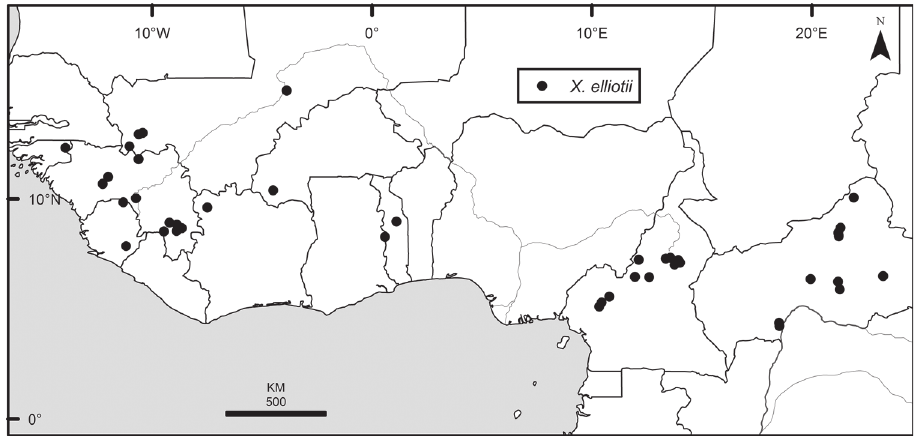
Figure 41. Distribution of Xylopia elliotii . Bolder lines represent country borders, fainter lines lakes and major